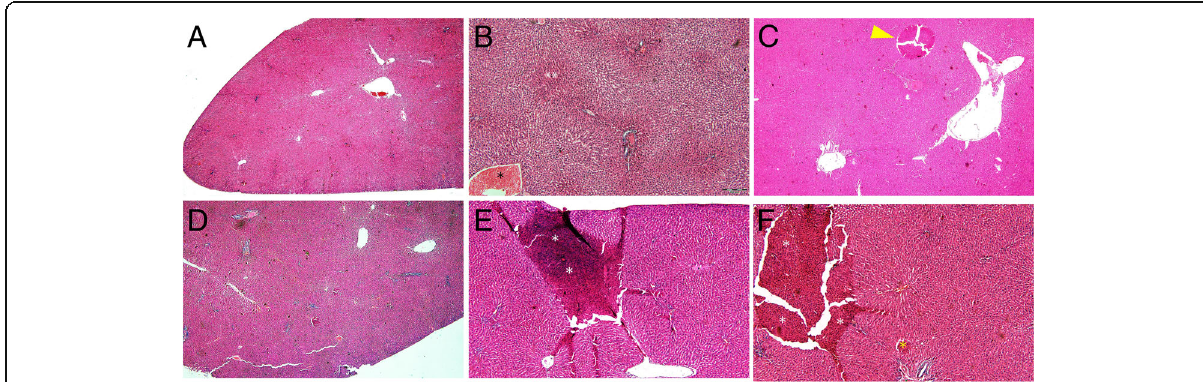
Fig. 1 Tissue sections representing histopathological results for liver examination using routine Hematoxylin & Eosin (H&E) stain. Upper panel ( a – c ) are representatives of female liver sections and lower panel ( d – f ) are representatives of male liver sections, respectively. a , d Images represents tissue sections of mice liver fed with 0% GM soybean meal (control) group, showing no changes in morphology of hepatocytes. b Representative image of female rat liver fed with 50% GM soybean showing basophilic focal necrotic areas (white stars) and blood congestion (yellow star). c Micrograph of represents tissue sections of female rat liver fed with 100% GM soybean meal, showing moderate focal angiectasis (yellow arrowheads). d , e Micrograph of represents tissue sections of male rat liver fed with50% and 100% GM soybean meal respectively, showing moderate focal and multifocal angiectasis (white stars), sporadic zones of coagulation necrosis (yellow stars). Scale bar is 200 μ m